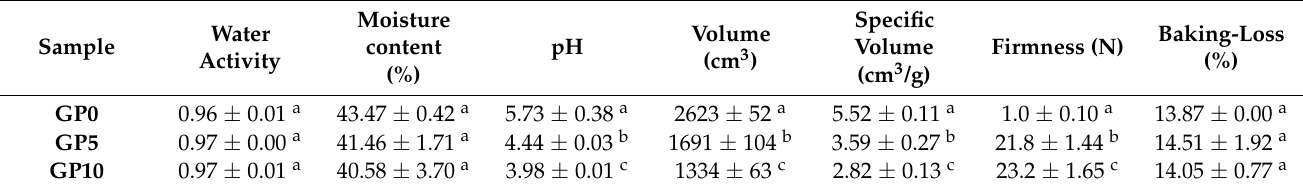
Table 4. Water activity, moisture content, pH, volume, and specific volume along with the firmness values and baking-loss of control bread (GP0) and bread fortified with grape pomace powder (GP5 and GP10).